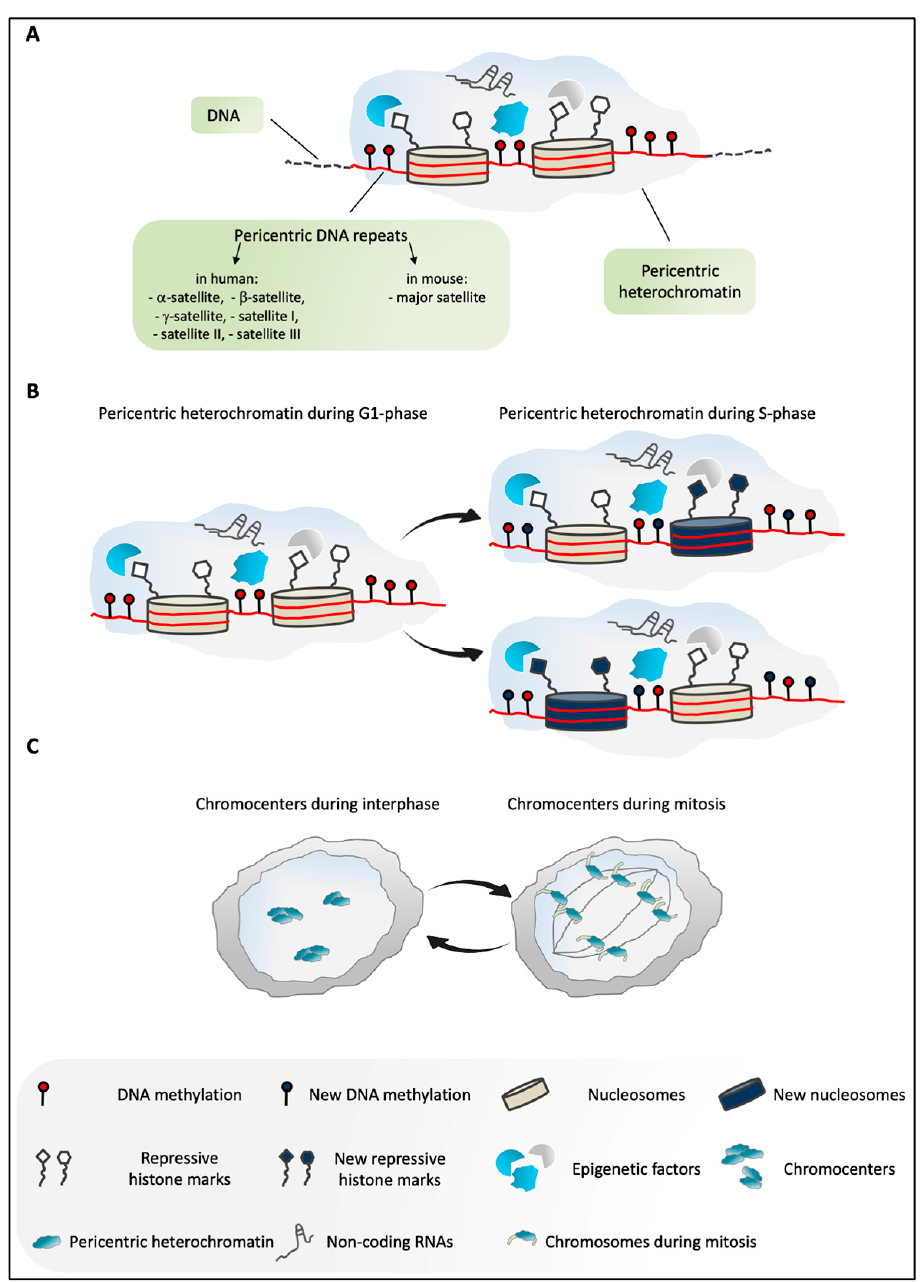
Figure 1. ( A ) Overview of pericentric heterochromatin (PCH) in mammals. PCH is constituted by highly methylated pericentric DNA repeats ( α -, β -, and γ -satellites, satellites I, II, III in humans; major satellite in mice) [9,16]. It is enriched in several epigenetic factors, non-coding RNAs, and repressive histone modifications [4,13]. ( B ) Schematic representation of PCH in G1 and S phases of the cell cycle in mammals. According to the current model, during DNA replication, PCH is assembled through the incorporation of both old and newly synthesized histones. Similarly, epigenetic marks are enriched at PCH, including DNA methylation and repressive histone modifications, and these are inherited from the parental structure and/or established ex novo by different epigenetic factors. These processes ensure faithful maintenance of the PCH structure and its repressive environment during the cell cycle [4,13]. ( C ) In murine cells in interphase, PCH of different chromosomes is organized in highly compacted structures, termed chromocenters. During mitosis, the dissociation of the chromocenters into individual chromosomes takes place [4,16].